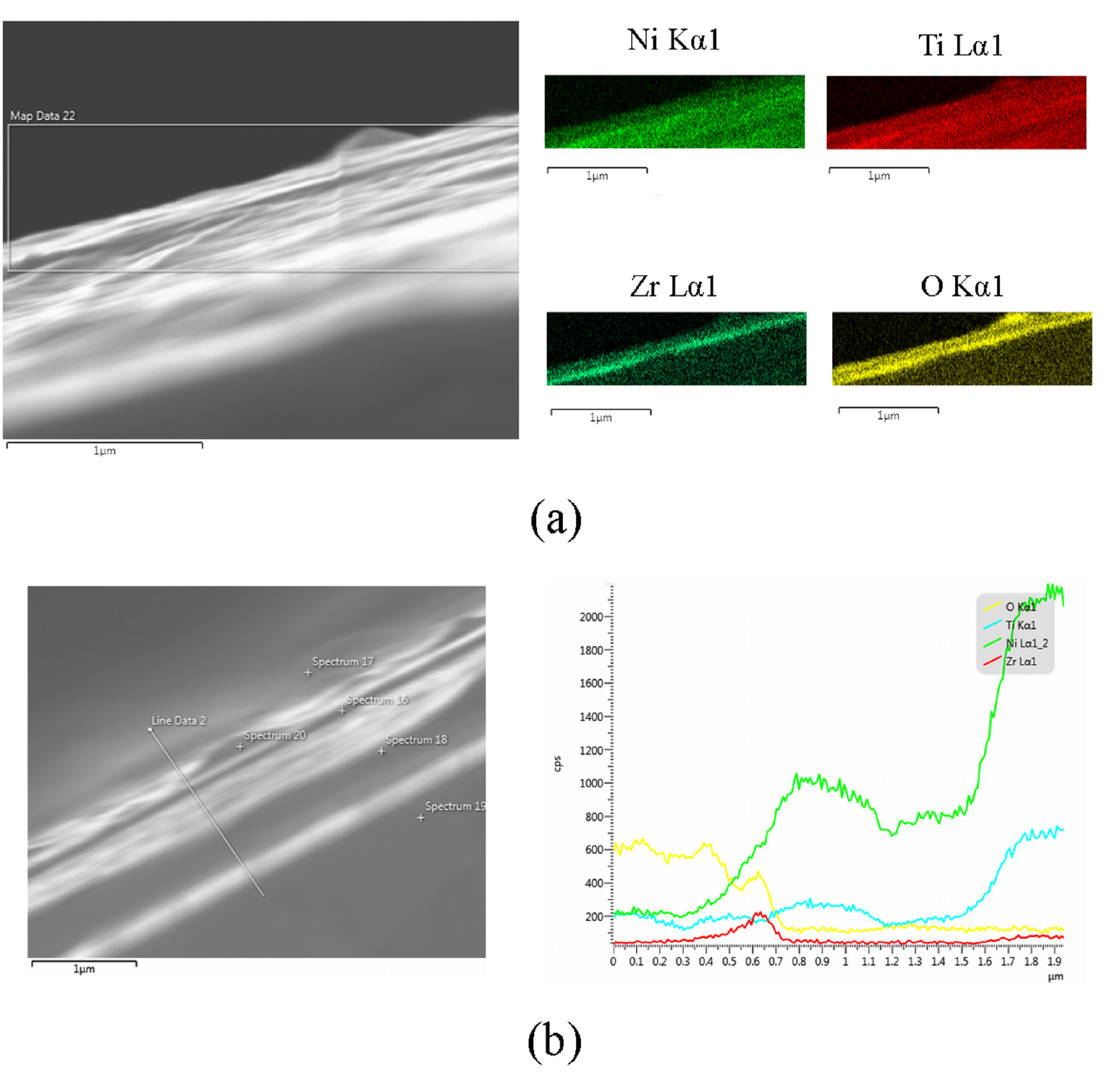
: (a) surface image after ion milling preparation, (b) elemental 2